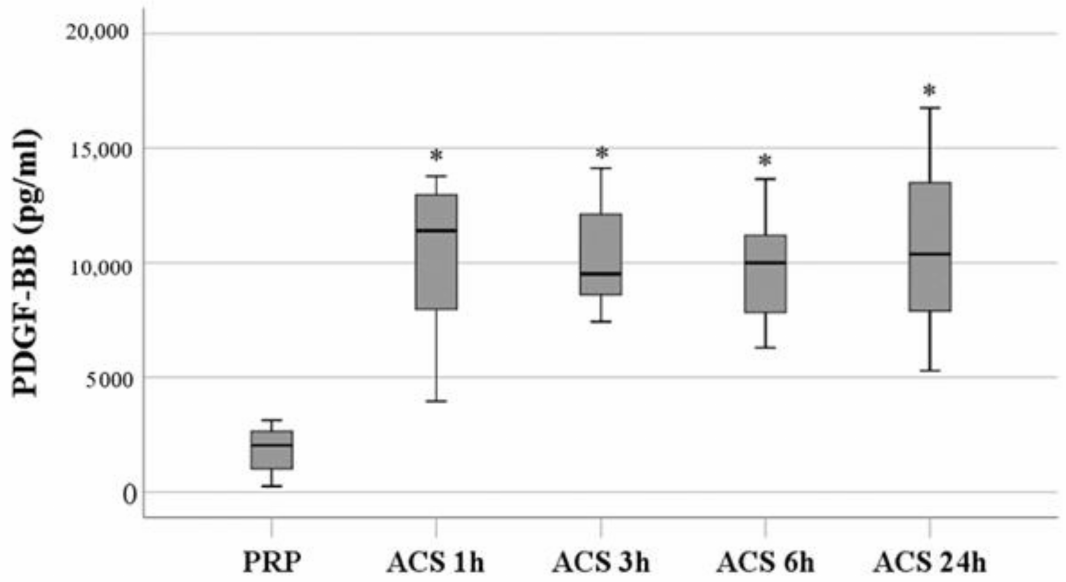
Figure 2. Platelet-derived growth factor (PDGF)-BB levels of platelet-rich plasma (PRP) and autolo- gous conditioned serum (ACS) with different incubation times. * indicates a significant difference as compared to